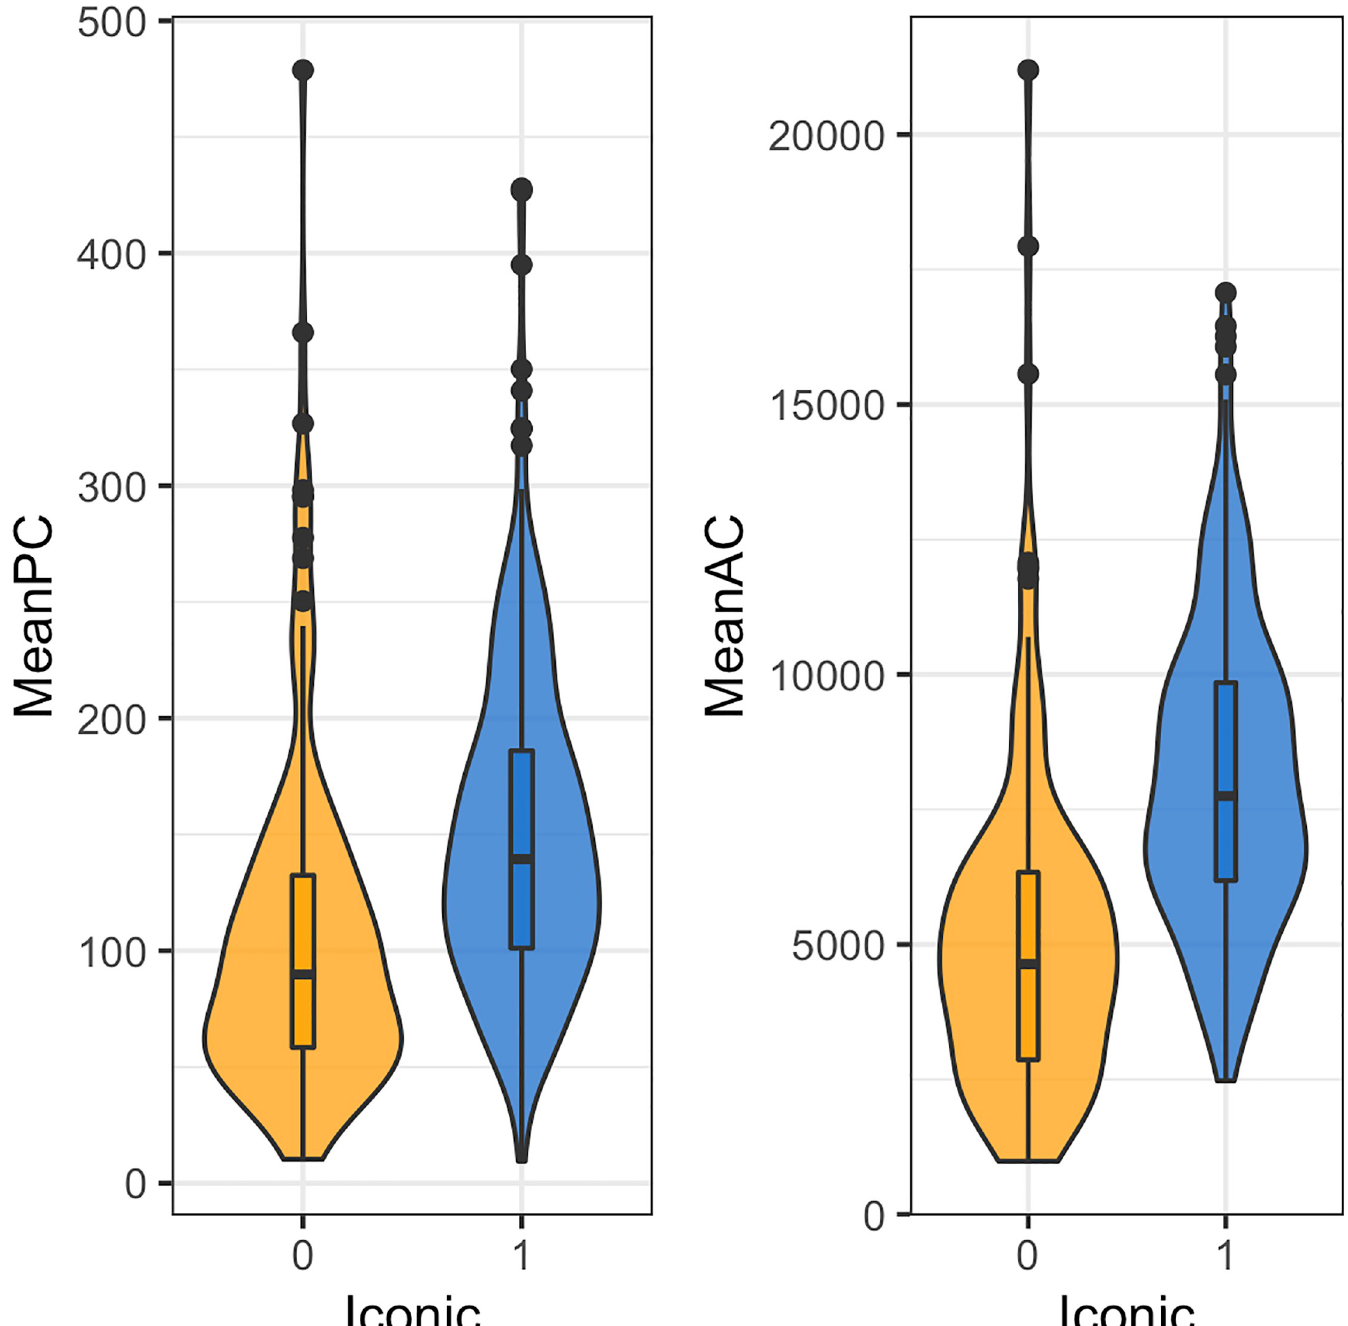
Fig 3. Distribution of iconic (blue) and non-iconic (yellow) motifs’ complexity scores, perimetric (left) and descriptive